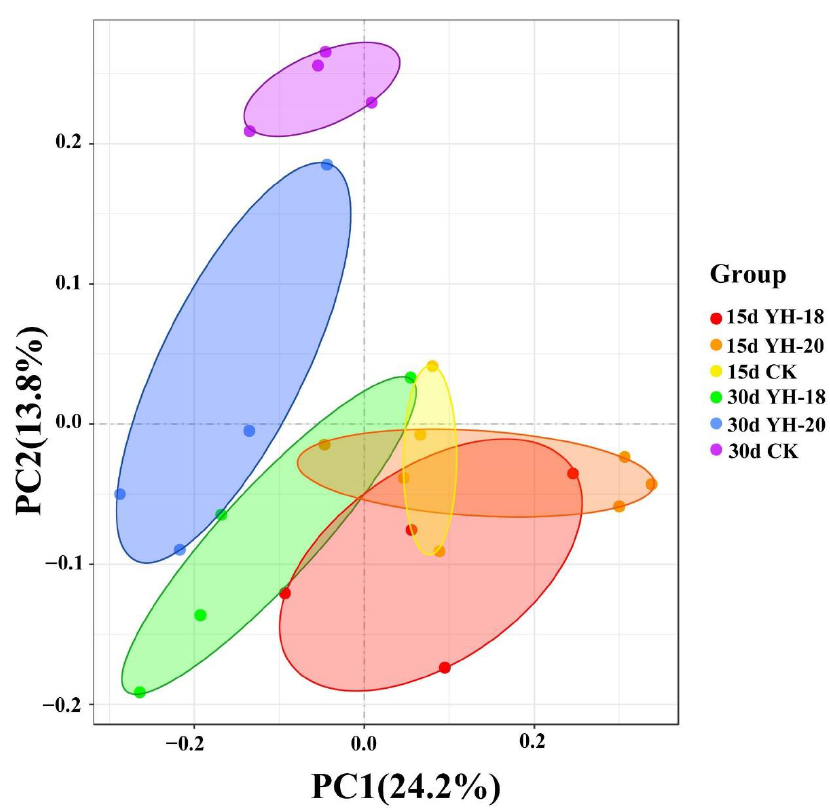
Figure 6. Principal coordinate analysis of 16S rRNA genes of total bacteria based on the weighted similarity index at 97% identity (operational taxonomic unit level). PC1 and PC2 explained 25.9% and 12.3%, respectively, of the variance.